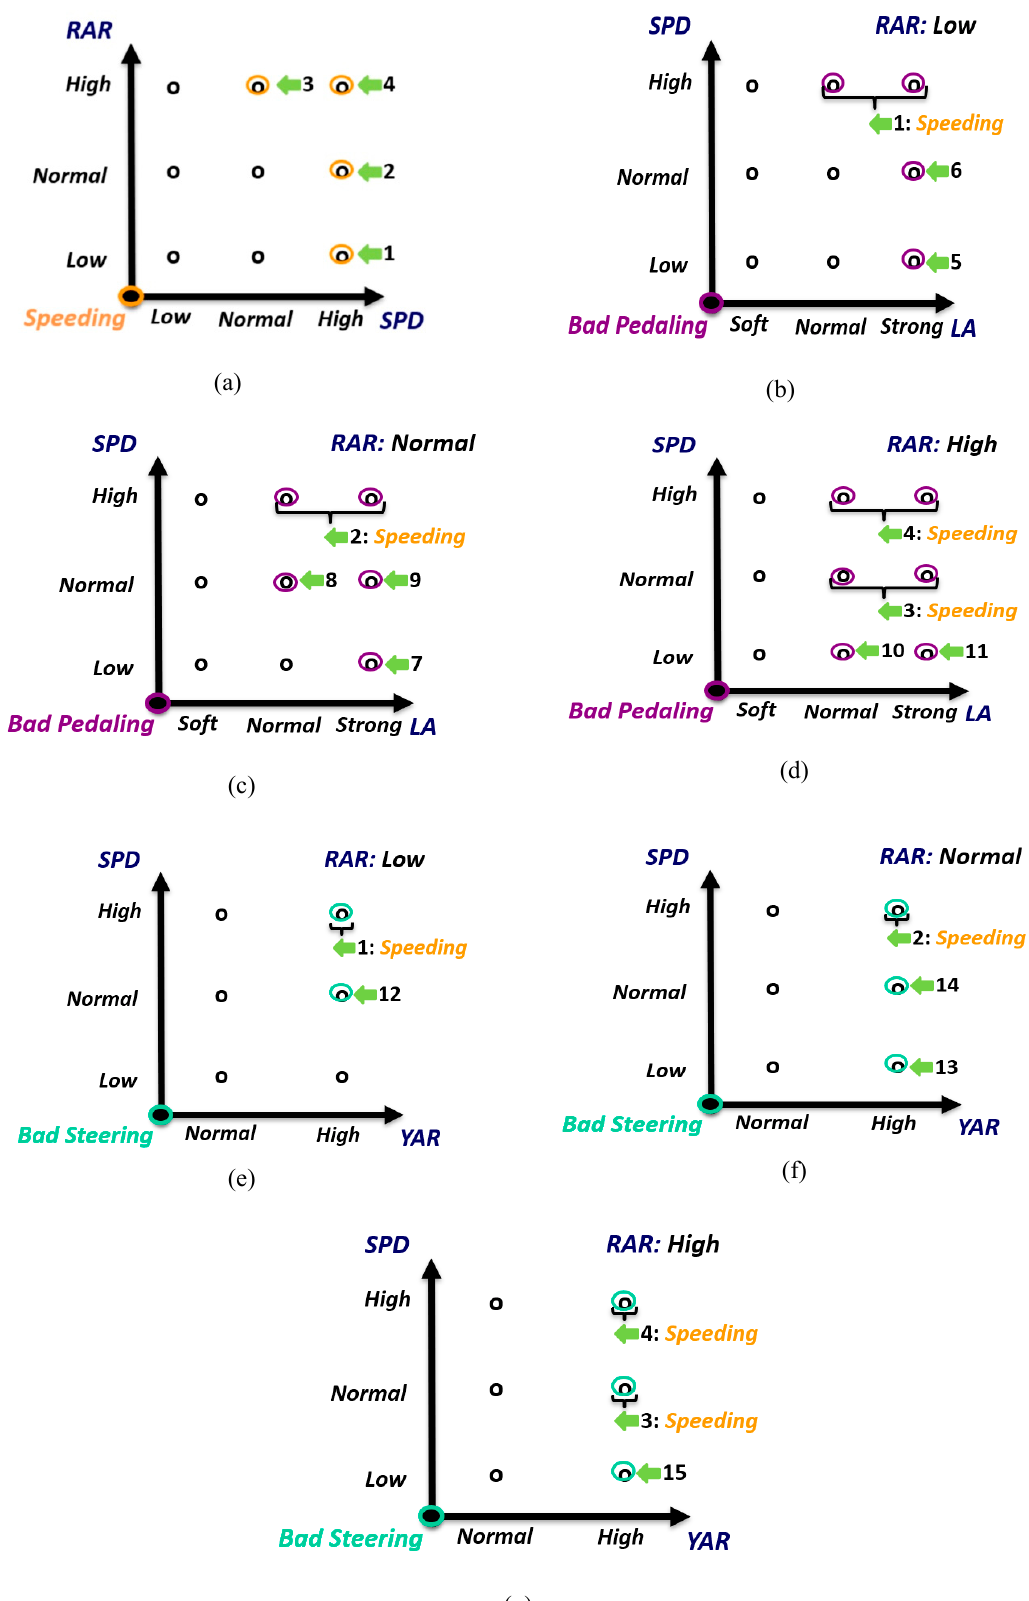
Figure 6. Fuzzy rule set selection process. ( a ) Speeding detection; ( b ), ( c ), ( d ) Bad Pedaling detection; and ( e ), ( f ), ( g ) Bad Steering detection.